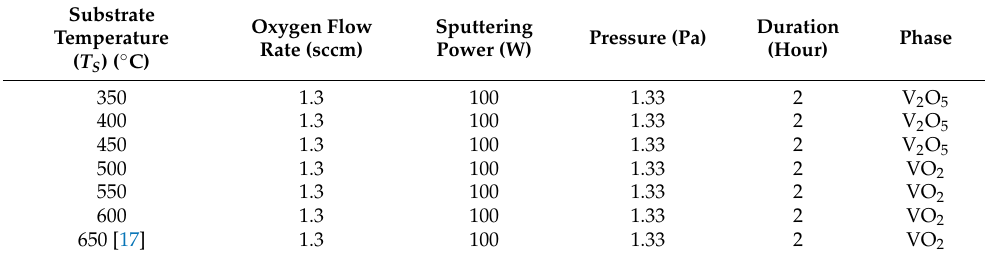
Table 1. Deposition conditions of VO 2 thin films on Si and sapphire